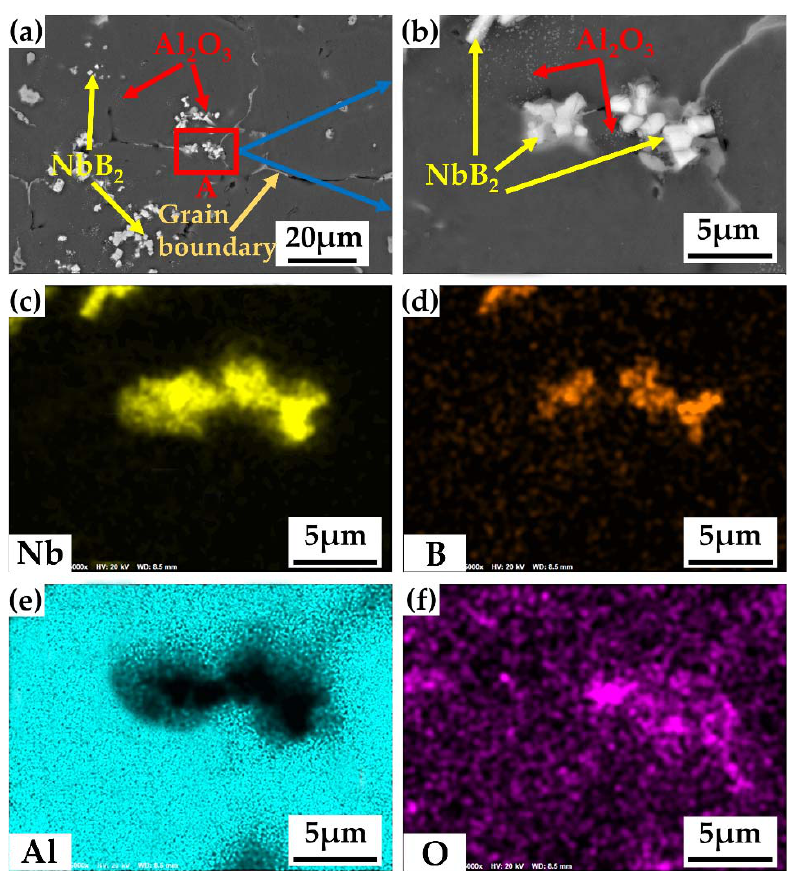
Figure 7. The particle morphology and a face ‐ scan study of a composite with 2.3 wt.% particle content: ( a ) the particle morphology and distribution under a microscope, ( b ) a close ‐ up of region A in Figure 7a, ( c ) the Nb element distribution, ( d ) the B element distribution, ( e ) the Al element distribution, and ( f ) the O element distribution.